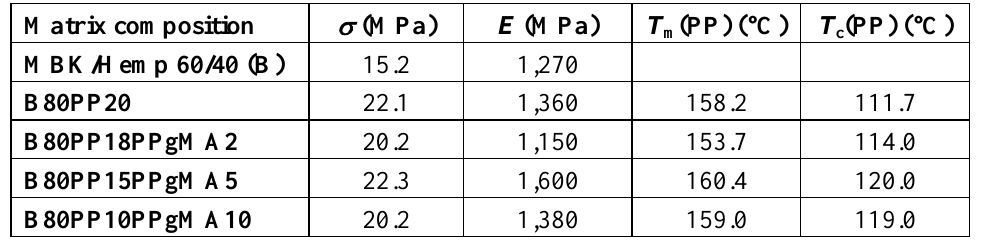
Table 2 . Mechanical and thermal properties of MBK/PP/PP-g-MA/Hemp composites. Matrix